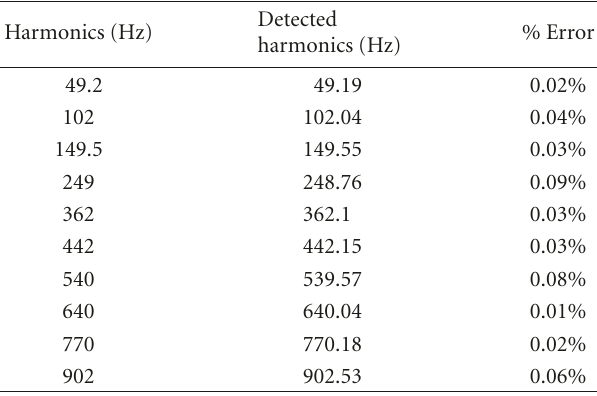
Table 3: Harmonics detection